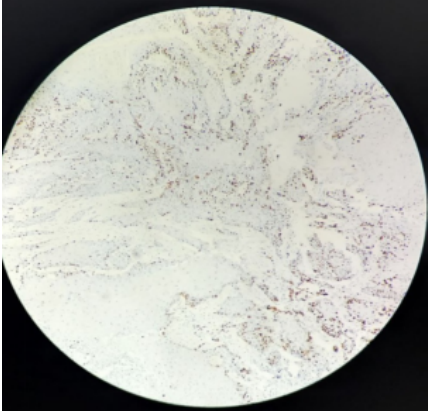
Figure 5. Photomicrograph of Ki67 immunohistochemical stain illustrating grade 4 positivity with 55% positivity (10x view)